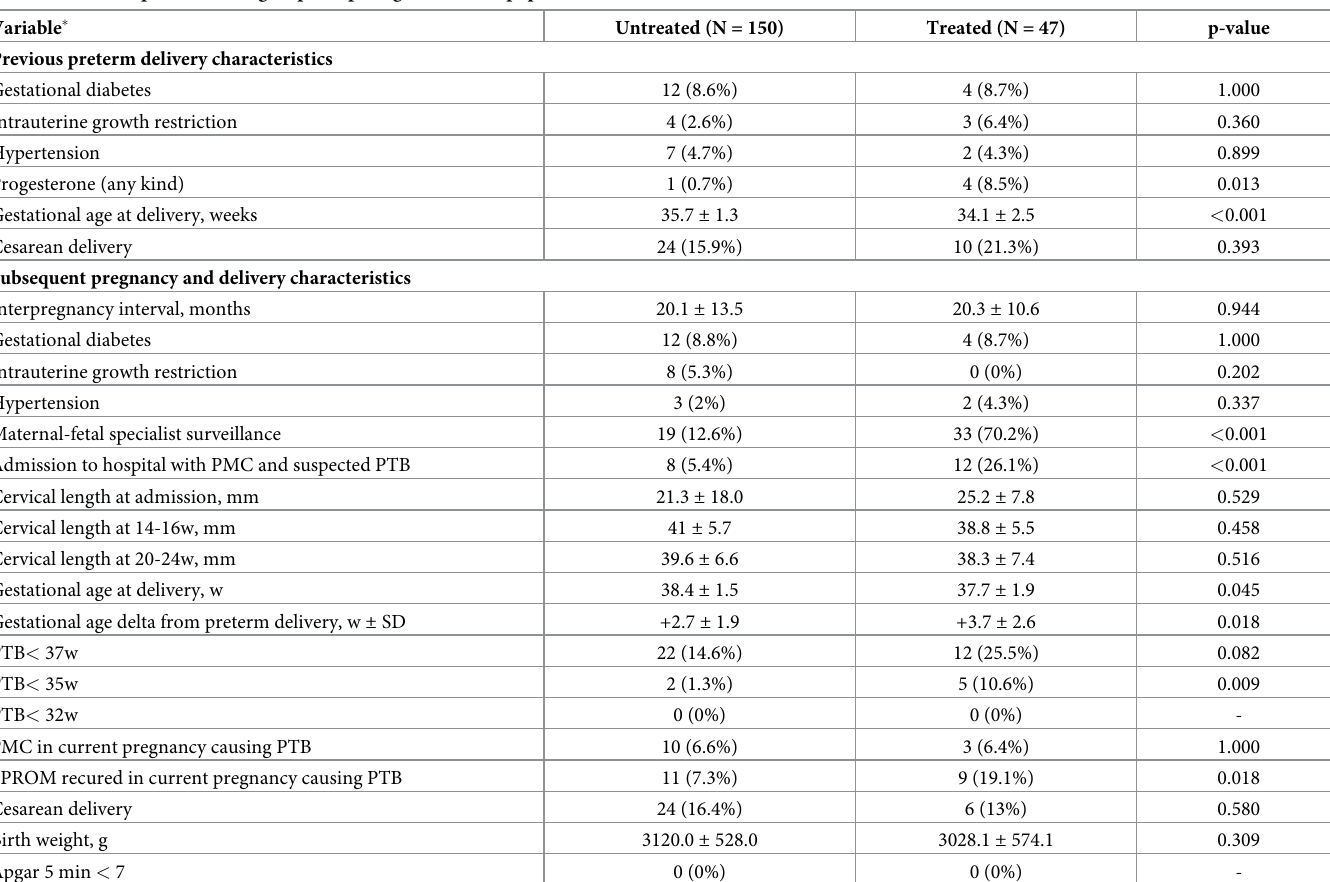
Table 2. Previous pPROM-PTB group comparing 17P treated population vs. untreated. Variable